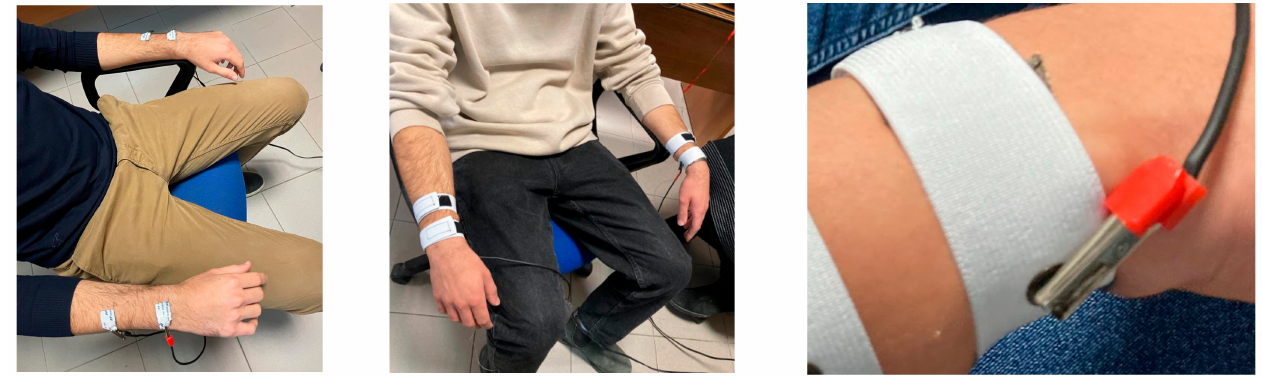
Figure 1. Setup adopted for the measurements with commercial ( left ) and textile electrodes ( middle and right